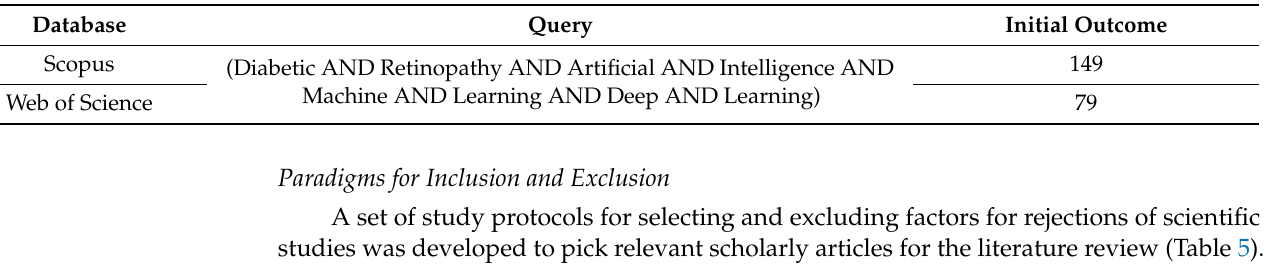
Table 4. Search terms